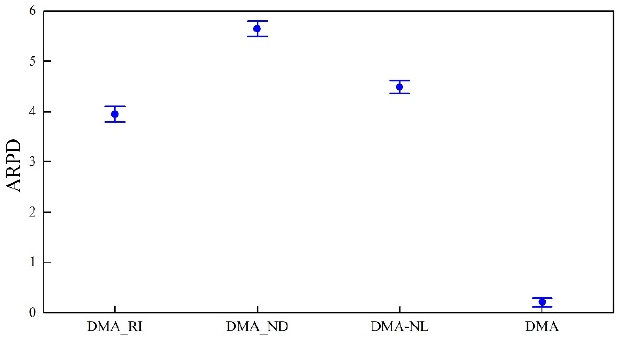
Figure 8. Mean plots with 95% confidence intervals for DMA and its variant algorithms.